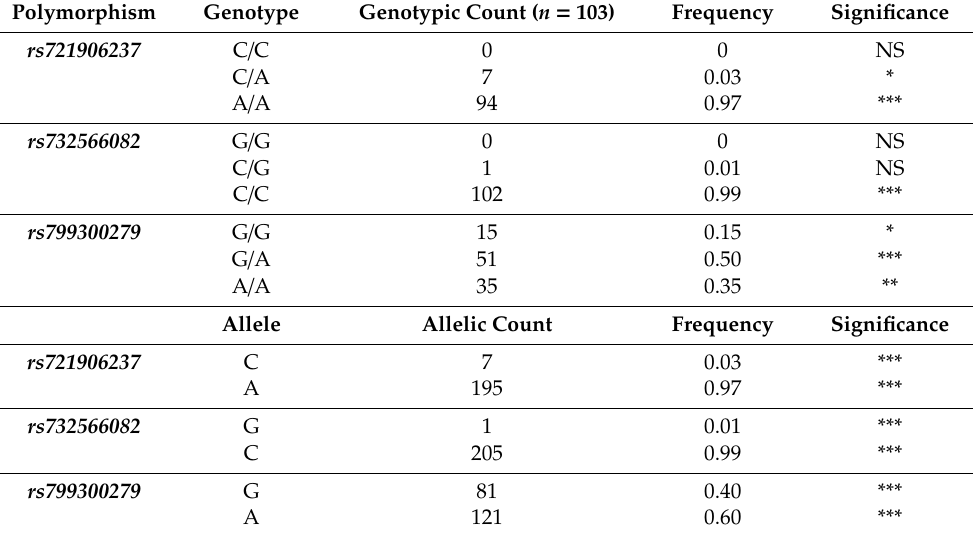
Table 5. Genetic diversity of selected N’Dama-specific polymorphisms in the CD14 gene promoter region. Polymorphism